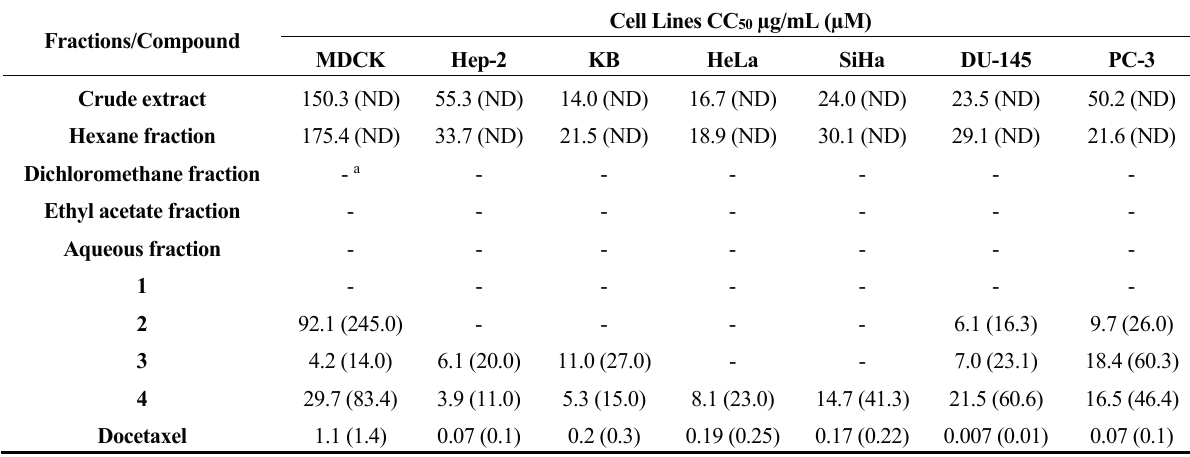
Table 2. Cytotoxic activity (CC 50 ) of extract, fractions and compounds isolated from A. fascicularis root bark.